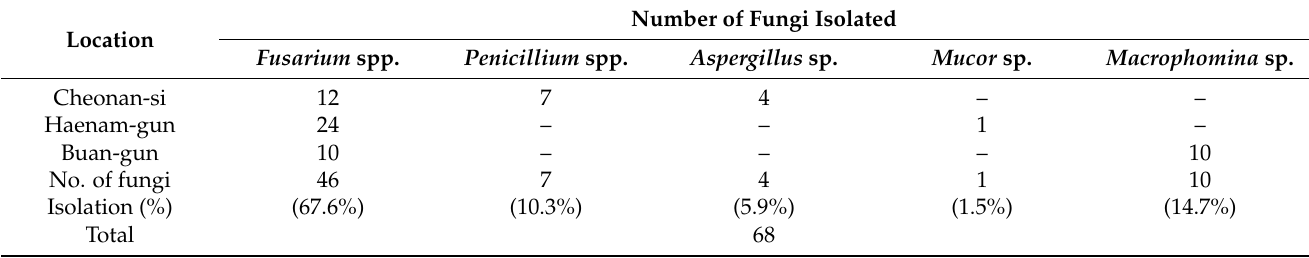
Table 1. Total number of fungi isolated from postharvest sweet potatoes in Korea during the study in 2021. Number of Fungi Isolated Location Fusarium spp. Penicillium spp. Aspergillus sp. Mucor sp. Macrophomina sp. Cheonan-si